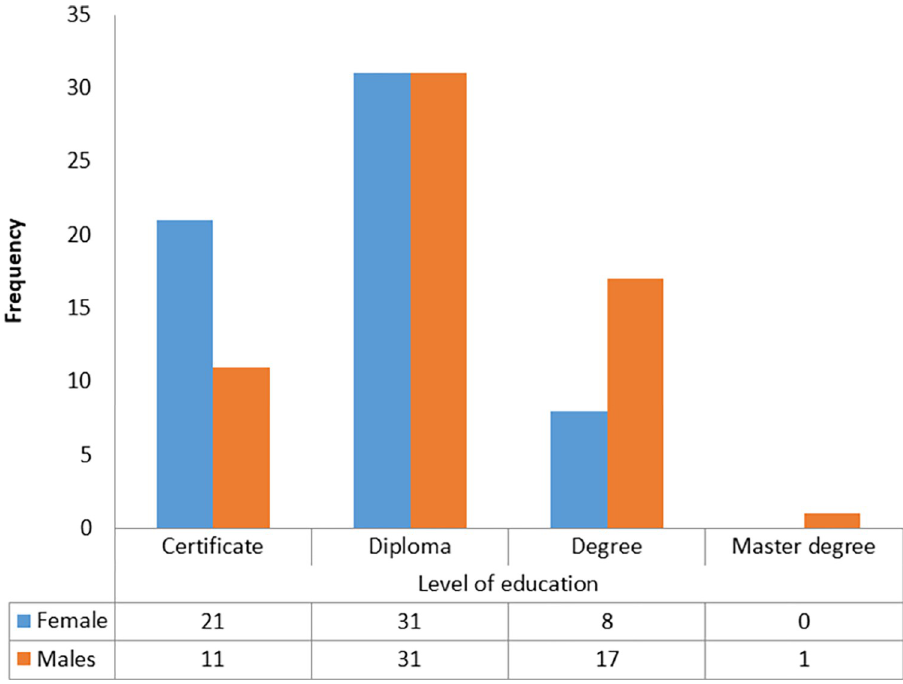
Fig 4. Distribution of participants by education